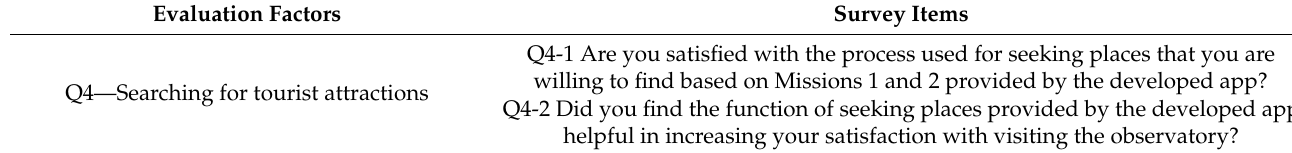
Table 4. Cont. Evaluation Factors Survey Items